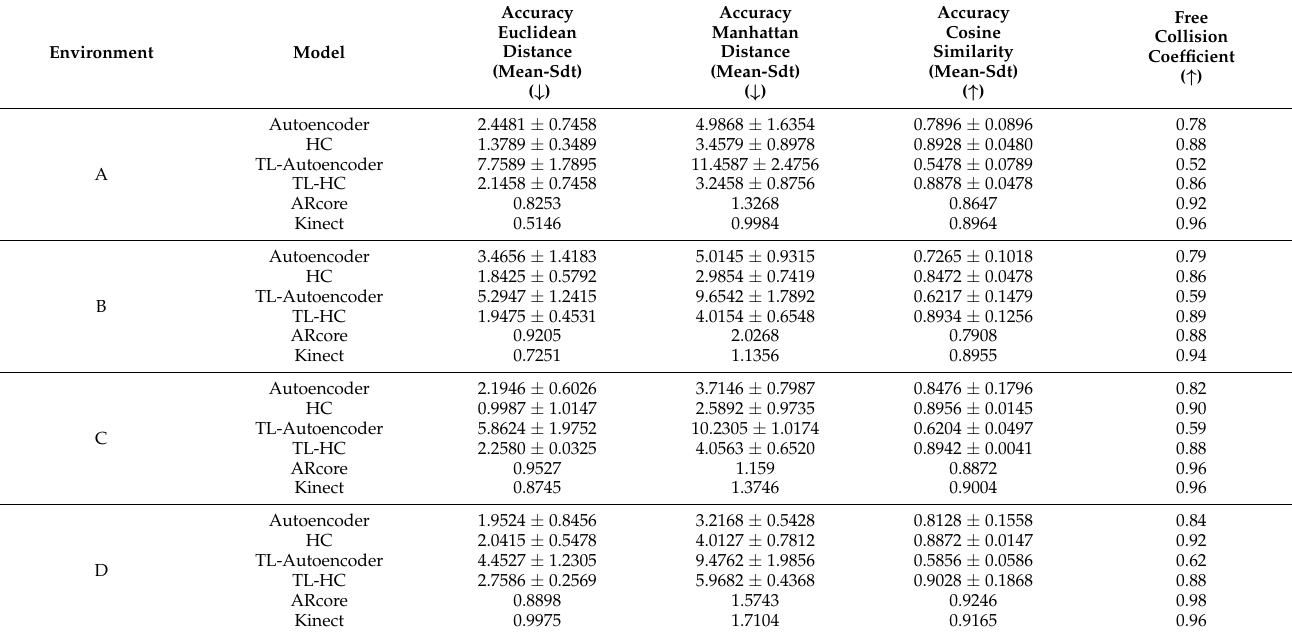
Table 3. Performance of each model to generate a path with 50 evaluations, where ( ↓ ) Low is better and ↑ Up is